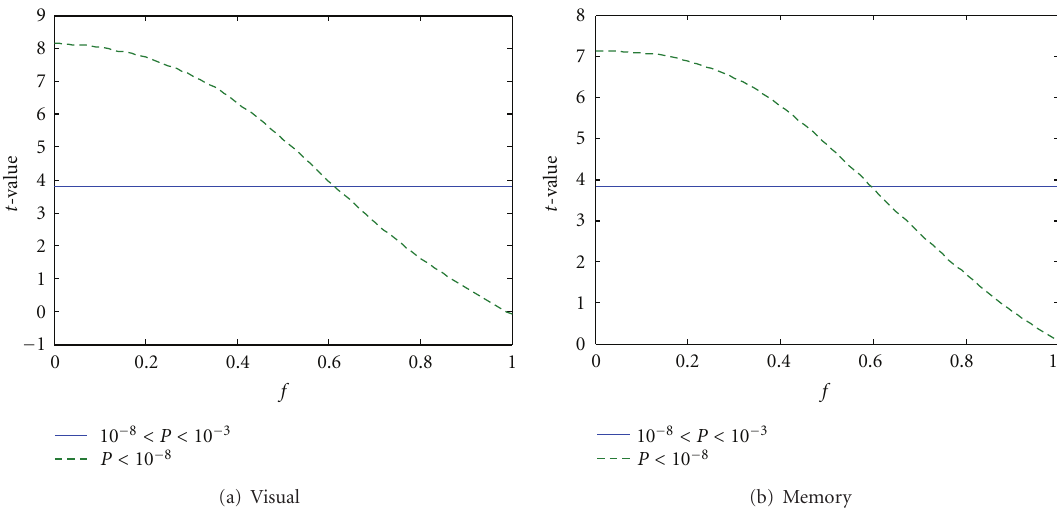
Figure 2: Determination of the proper value for the noise fraction f for pseudoreal data. The solid horizontal lines represent the medians of t -statistics at the significance level 10 − 8 < P < 10 − 3 (uncorrected) for the contrasts V-F (a) and E-C (b) by applying GLM-NS on real fMRI activation data. The dashed curves are the medians of the t -statistics of activation-defined voxels for the contrasts V-F (a) and E-C (b) by applying GLM-NS on pseudoreal data where the true activations were defined by thresholding real activation data using a very high significance level ( P < 10 − 8 uncorrected) and adding resampled noise according to (16) for di ff erent noise fractions f ∈ [0,1]. The medians of the t -value matched at around f = 0 . 6. Therefore, we picked two values for f : f = 0 . 55 representing the low noise case and f = 0 . 65 representing the high noise case.